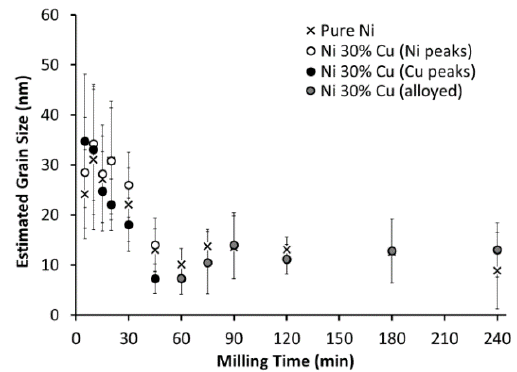
Figure 1. XRD patterns collected after listed milling times for ( A ) Pure nickel and ( B ) Ni 30 at % Cu. Figure 2. Grain size analysis for pure Ni and Ni 30 at % Cu after the milling times indicated. Error bars represent one standard deviation from the mean.